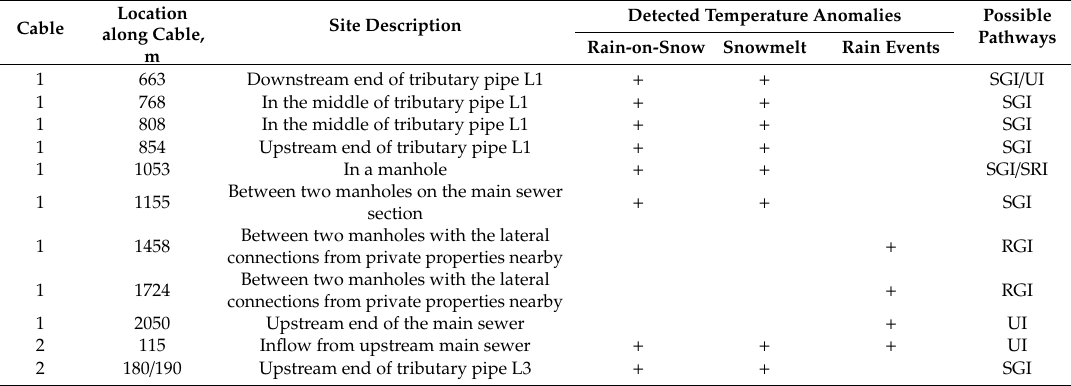
Table 2. Summary of identified temperature anomalies (marked with plus sign) during rain-on-snow, snowmelt and rain events and their possible pathways (UI—upstream inflow) (discussed further in the discussion section). RGI/SGI—rainfall/snowmelt induced groundwater infiltration; SRI— snowmelt runoff inflow; UI—upstream inflow.